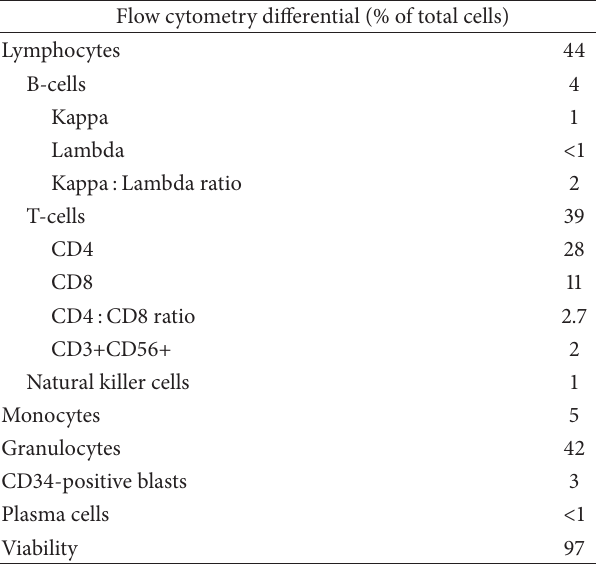
Figure 3: MDS FISH: chromosomes 8 and 20. Table 1: Flow cytometry after 3 weeks of lenalidomide treatment.